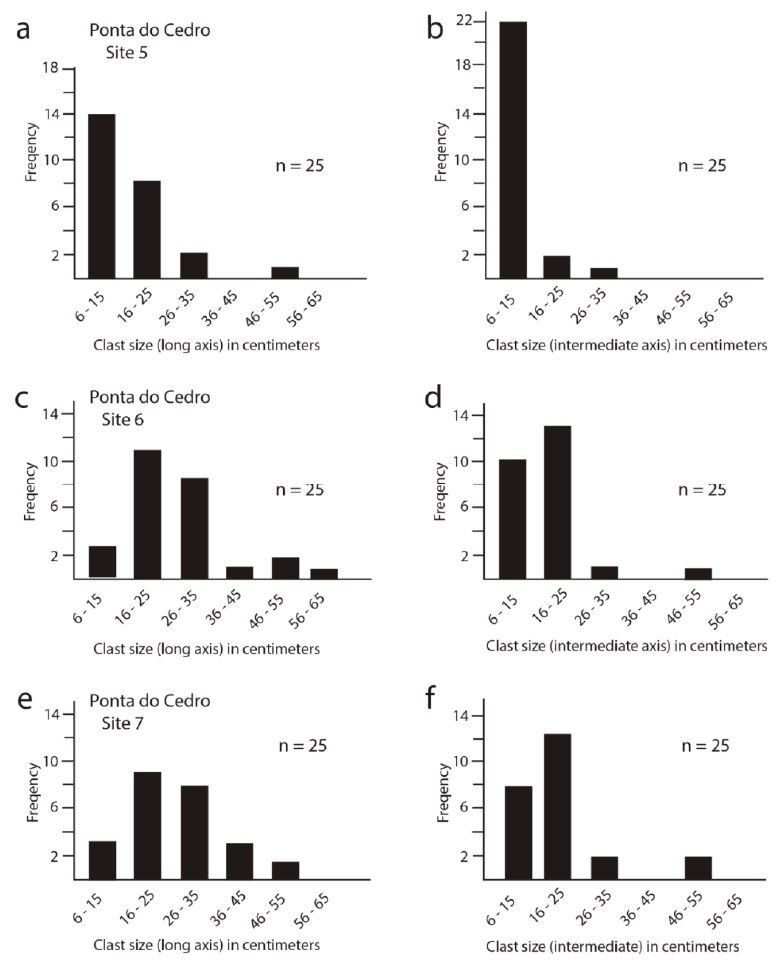
Figure 9. Bar graphs used to appraise variations in the long and intermediate axes on basalt clasts from three sites of correlated Pleistocene CBDs at Ponta do Cedro; ( a ) Long-axis length from clasts at site 5; ( b ) Intermediate-axis length from clasts at site 5; ( c ) Long-axis length from clasts at site 6; ( d ) Intermediate-axis length from clasts at site 6; ( e ) Long-axis length from clasts at site 7; ( f ) Intermediate-axis length from clasts at site